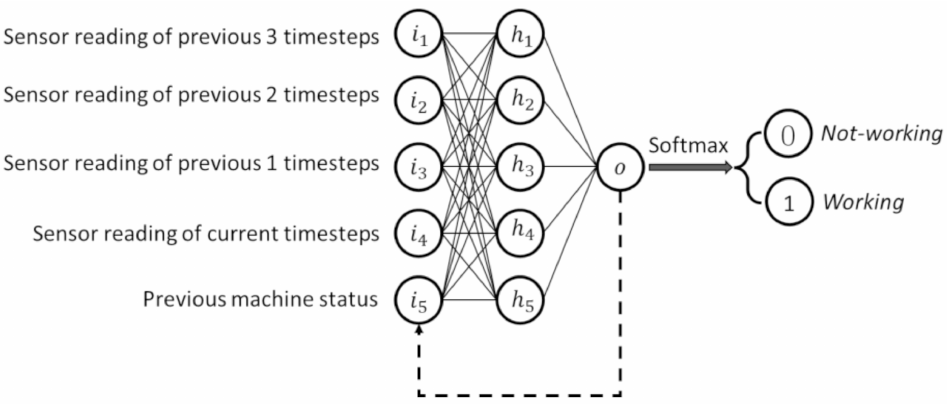
Figure 3. The neural network structure to capture the single machine